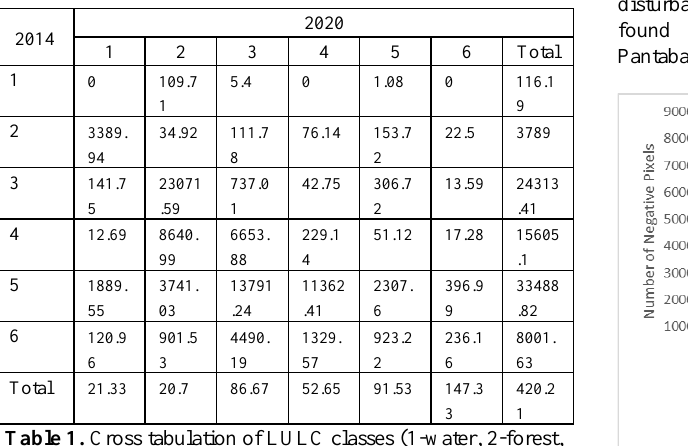
Figure 5. Number of negative NDMI pixels per town in Pantangan-Carranglan Watershed for 2014 and